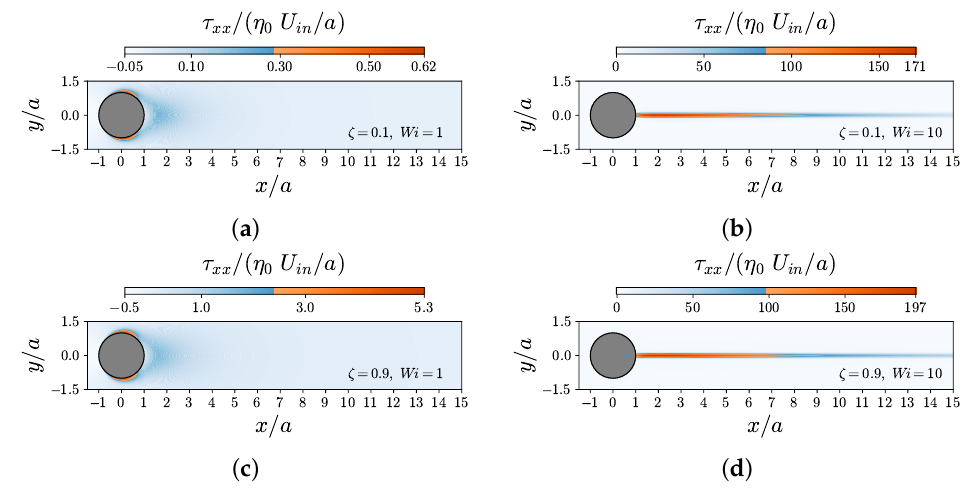
Figure 5. Contours of the dimensionless normal component of the polymeric extra-stress tensor τ xx for the Oldroyd-B fluid at Re = 1 for different values of ζ and Wi : ( a ) ζ = 0.1 and Wi = 1, ( b ) ζ = 0.1 and Wi = 10, ( c ) ζ = 0.9 and Wi = 1, and ( d ) ζ = 0.9 and Wi =